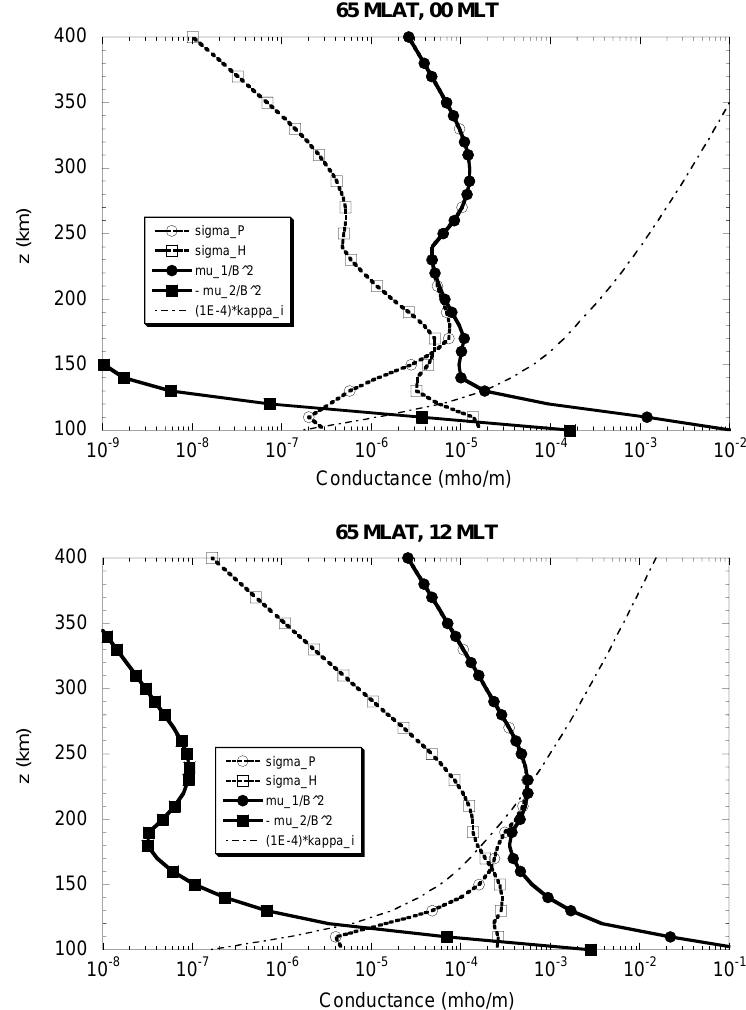
Fig. 1. Pedersen and Hall conductivities ( σ P and σ H , dashed lines) used in Eq. (10) as the coefficients for calculating ion drag and the Figure 1 improved coefficients ( µ 1 /B 2 and − µ 2 /B 2 , solid lines) in current parameterization of Eqs. (6) and (7) for ion drag. The thin dash-dotted lines represent the ratio of the ion cyclotron frequency to the ion-neutral collision frequency scaled by 10 − 4 . The computations are done based on the NRLMSISE-00 model atmosphere at 65 ◦ N magnetic latitude and the IRI90 ionospheric model. The A p index and the 10.7-cm solar radio flux (in units of 10 − 22 Wm − 2 Hz − 1 ) used in computations are 4.0 and 150.0, respectively. The upper and lower panels are for the midnight and noon magnetic local times,